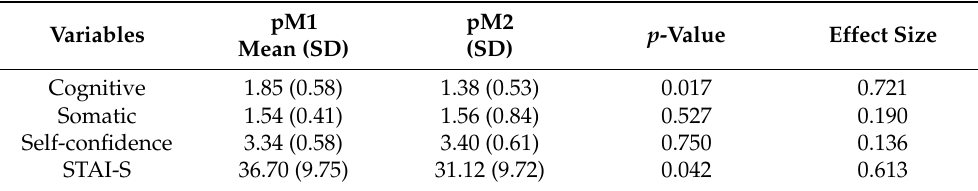
Table 3. Precompetitive anxiety values before the first and the second match of the ITF Junior Davis Cup.